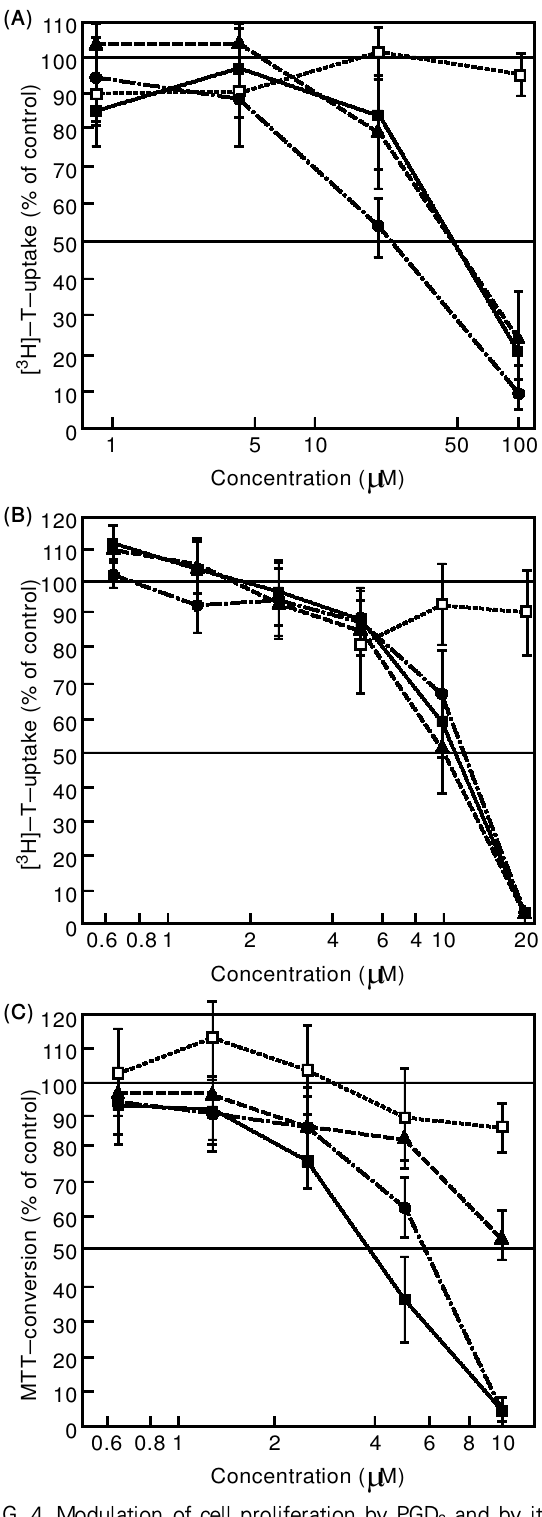
FIG. 4. Modulation of cell proliferation by PGD 2 and by its metabolites. Results obtained in a THP-1 monocytic cell line (human) (A), a HL-60 myeloid leukemic cell line (human) (B) and a murine autonomous mast cell line (C) are demon- strated. Results are expressed in percentage of control of [ 3 H]-T-uptake or MTT-conversion. PGD 2 ( j ), PGJ 2 ( m ) and D 12 -PGJ 2 ( d ) show distinct antiproliferative activity. Indom- ethacin ( h ) had no significant effect on cell proliferation. Experiments were performed in quadruplicates (mean ±